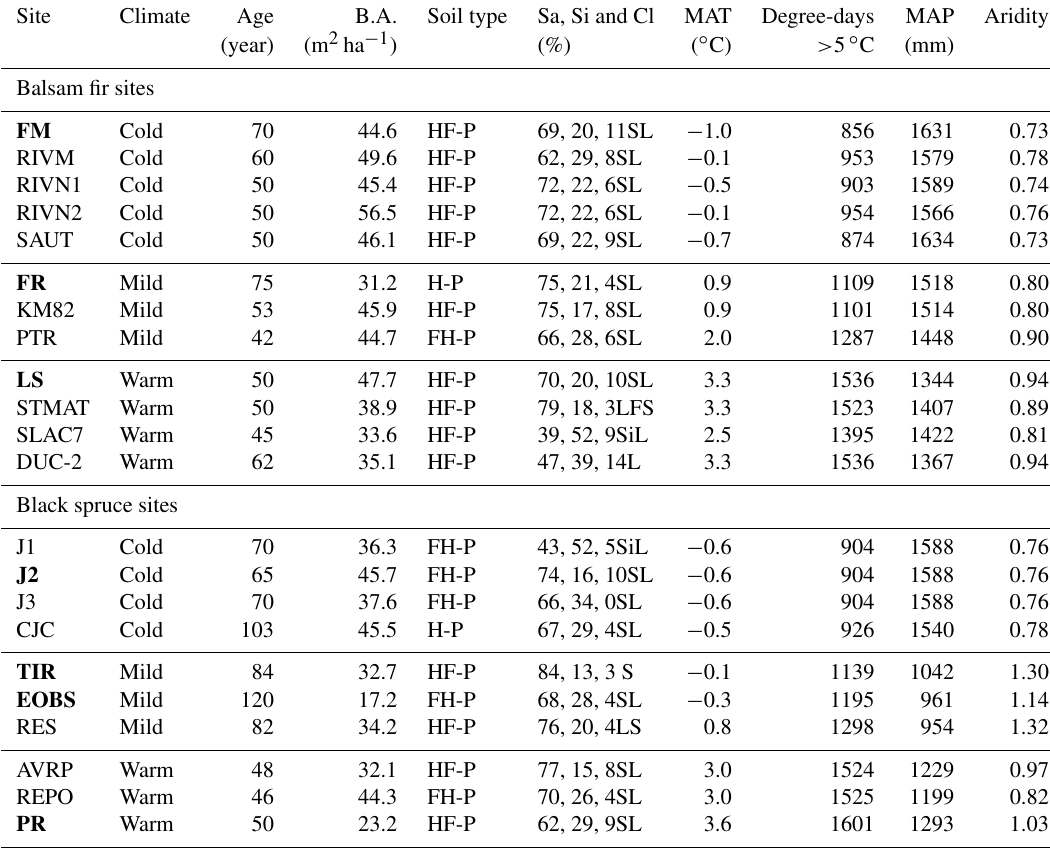
Table 1. Site characteristics. Intensively studied sites are marked in bold characters.